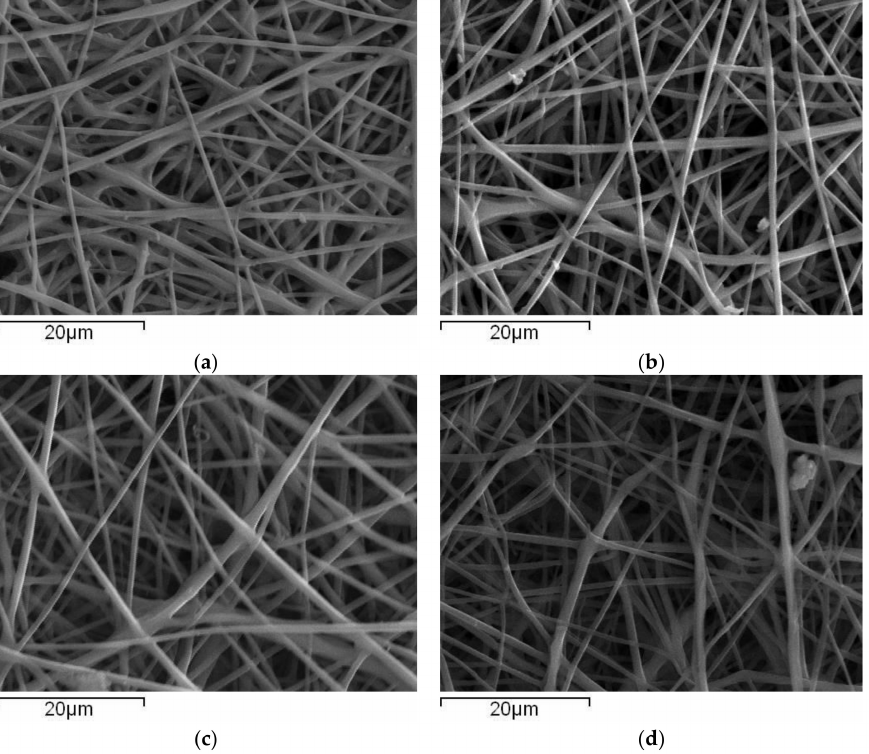
Figure 1. SEM images of electrospun cellulose acetate fibers containing ( a ) 0.0% wt., ( b ) 1.5% wt.,